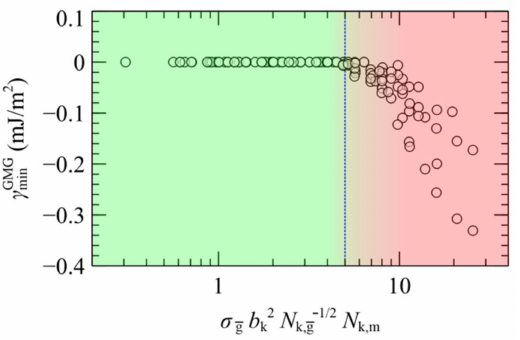
Figure 16. Well depth of PMF GMG as a function of σ g b k 2 N k, g − 1/2 N k,m . Green/red shades illustrate regimes with repulsive/attractive interactions between the opposing plates. The vertical dashed line is a guide to the